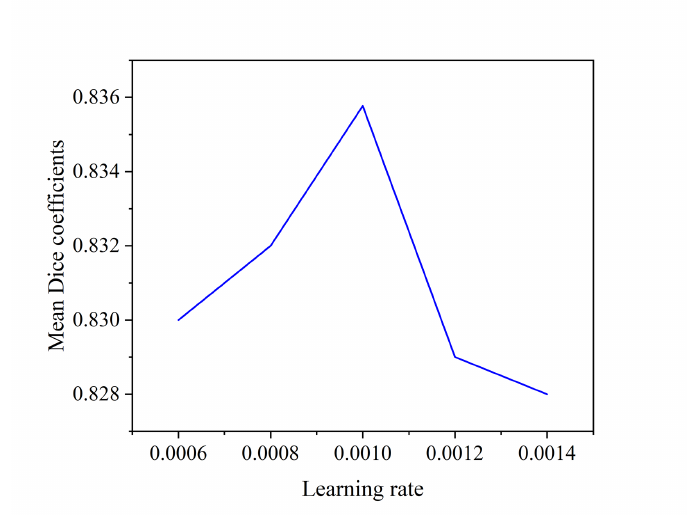
Figure 8. Average segmentation Dice coefficients of MVKS-Net at different learning rates.